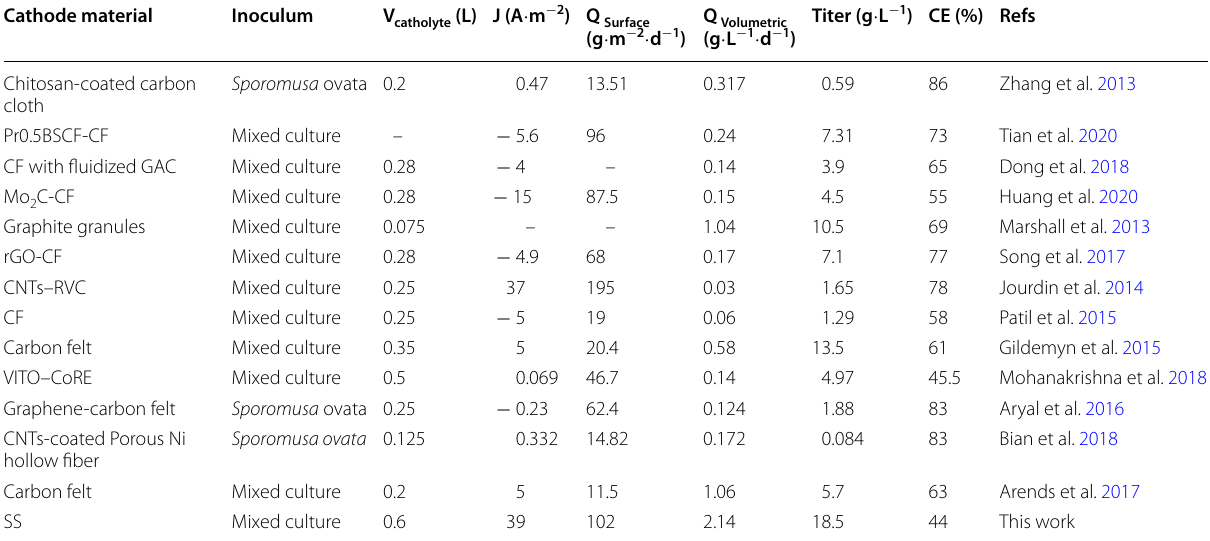
: Surface production rate; Q Surface